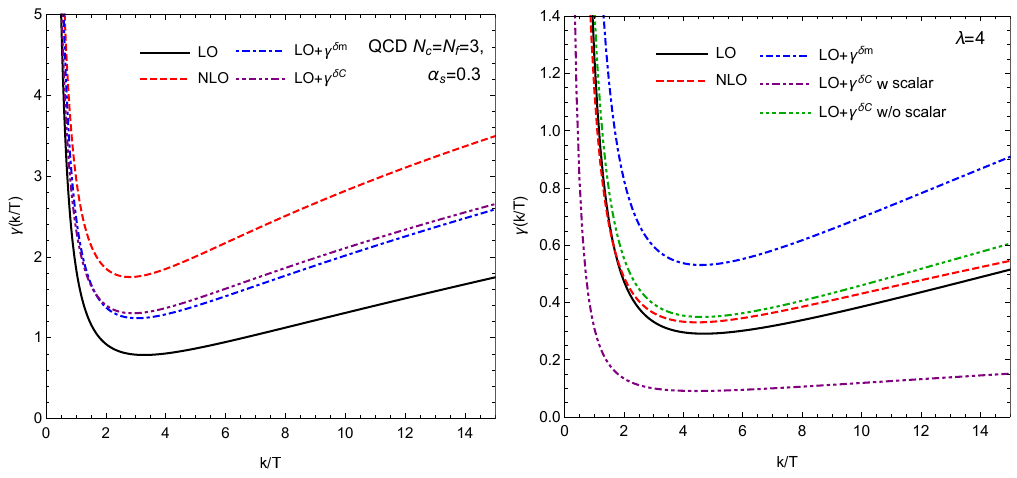
Figure 12 . Left: the separate sum of the LO γ with each of the two NLO corrections γ δm and γ δ C in QCD with N c = N f = 3, α s = 0 . 3. The results are taken from [21] and are normalized by the QCD leading-log coefficient. On the right we plot the same in = 4 SYM for λ = 4, with N the addition of the extra curve for γ δ C where δ is taken without the scalar contribution (3.6), C corresponding to the QCD δ . In both cases the full NLO collinear emission rate, γ (NLO) , is a sum C of the two corrections γ δm and γ δ C and of the leading order result γ (LO)